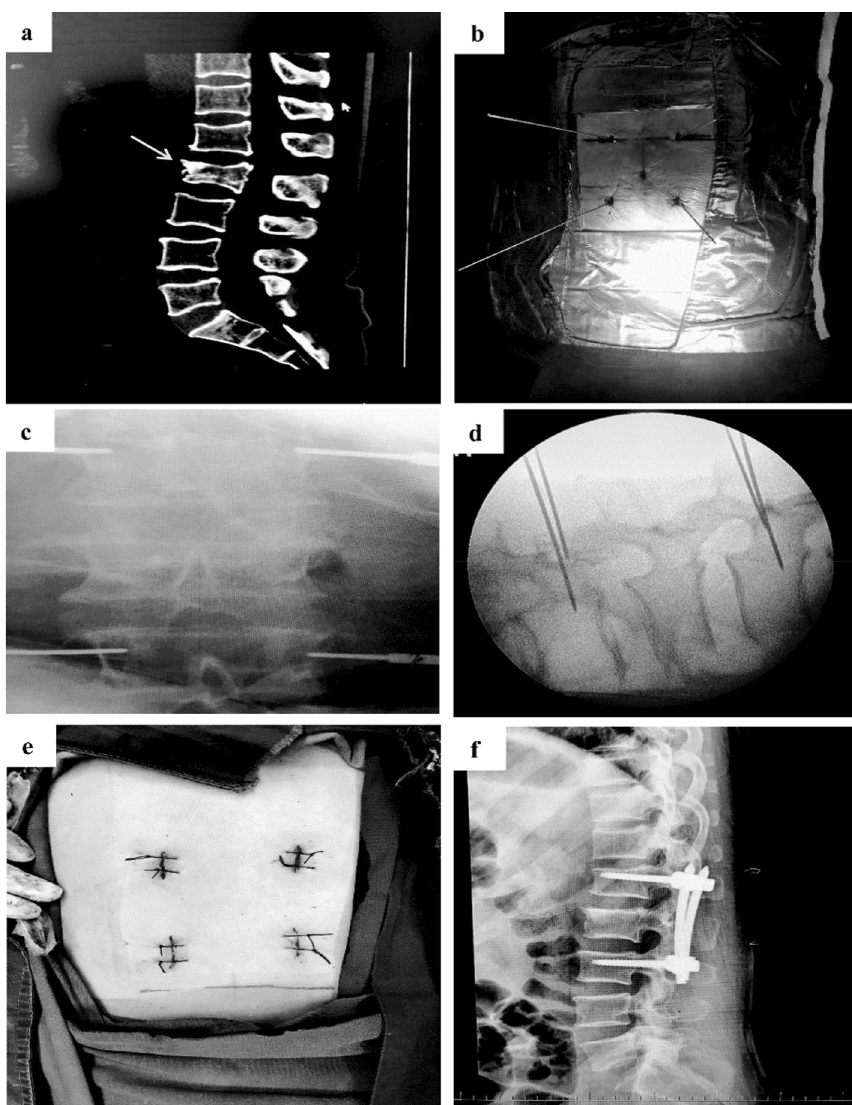
Figure 3. Reduction of vertebral compression fractures with percutaneous pedicle screw internal fixation using the proposed locator. Graph ( a ) shows a CT image of a vertebral compression fracture (lumbar #2). Graph ( b ) illustrates that the Kirschner wires were inserted into the pedicles of both sides of the lumbar #1 and #3 guided by the locator. Graphs ( c ) and ( d ) show that the accuracy of pedicle guide needle placement was confirmed by 2D fluoroscopy. Graph ( e ) displays the closed incisions. Graph ( f ) depicts DR image taken